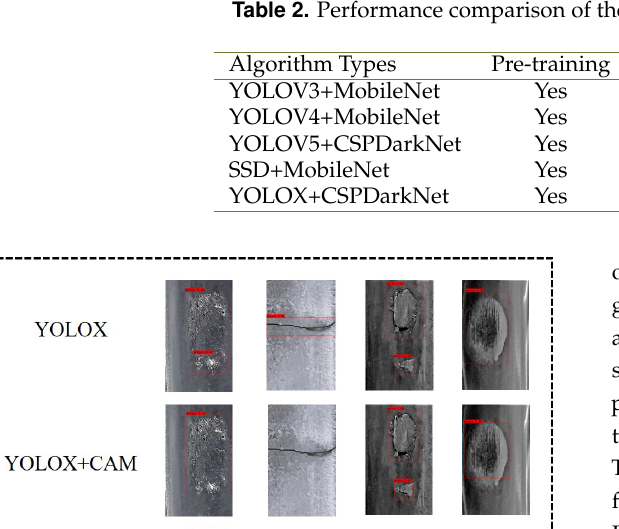
Table 2. Performance comparison of the different real-time algorithms.